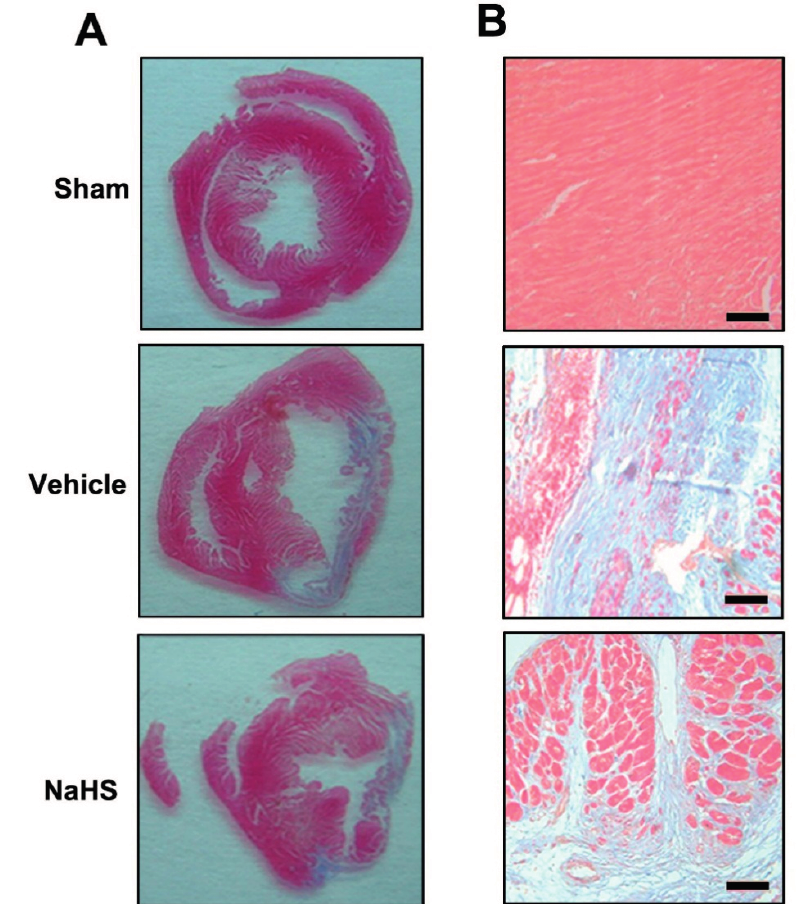
Figure 1. Sodium hydrosulfide (NaHS) inhibited fibrosis in the border zone of infarcted myocardium. ( A ) Representative Masson’s staining of cardiac fibrosis; ( B ) High-magnification microphotographs of Masson-stained sections showed the extent of cardiac fibrosis. Scale bar = 25 μ M; and ( C ) Quantitative analysis of fibrosis area (percentage of left ventricular (LV) area) at 42 days post MI. n = 6, # p < 0.01 vs . sham-operated rats; * p < 0.01 vs. vehicle-treated